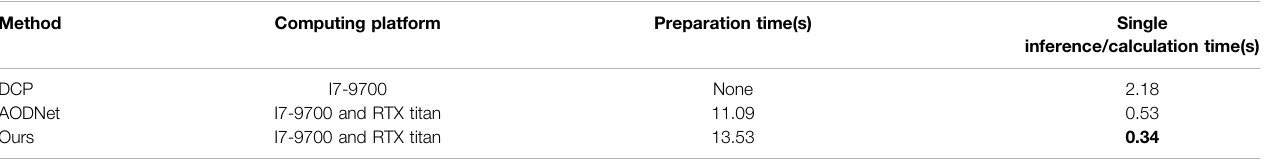
TABLE 3 | Comparison of calculating time using different methods. Method